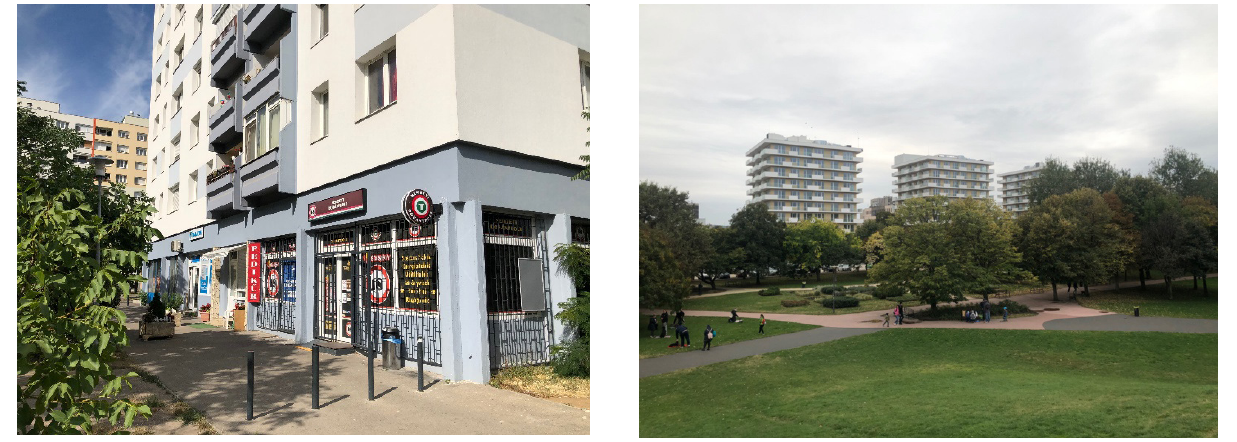
Figure 5. Contemporary residential complex along the